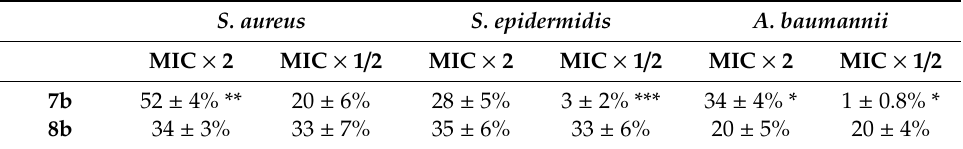
Table 2. Percentage (%) of inhibition of biofilm